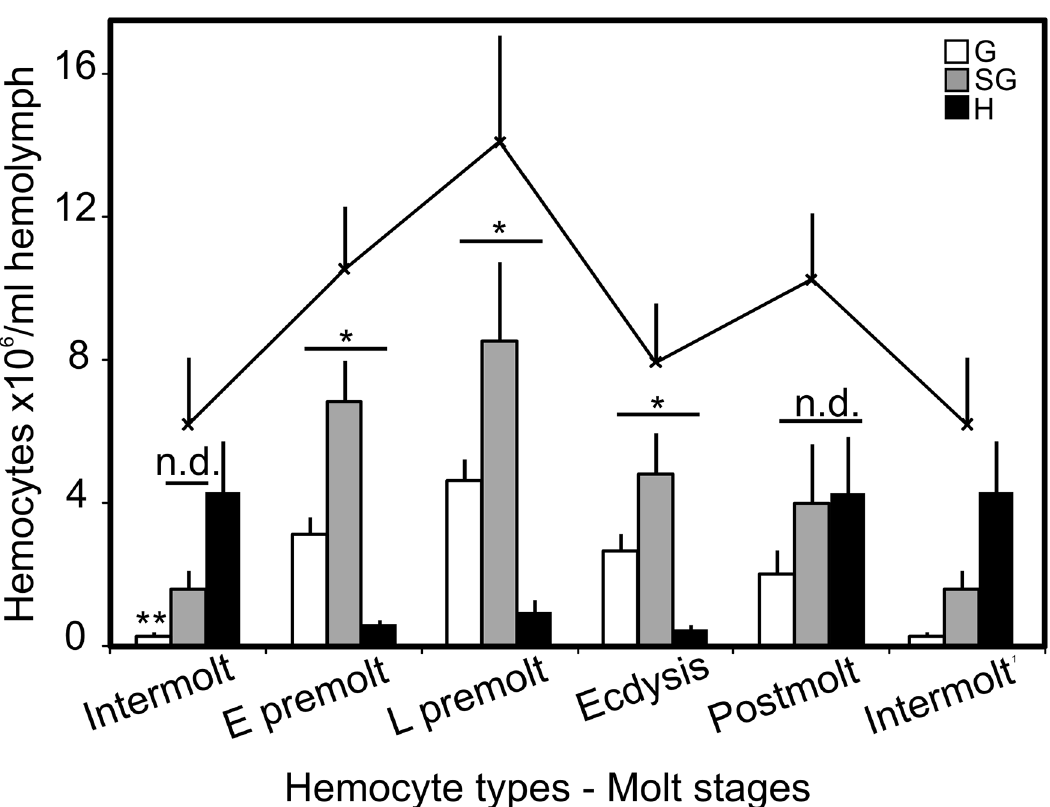
Fig 4. Differential hemocyte counting (DHC) during the molt cycle of C . sapidus using the flow cytometry analysis. The values of THC (solid line) do not significantly differ among the different molt stages (n = 18). Each bar represent a hemocyte type. n.d. = no difference; the ‘ * ’ and ‘ ** ’ denote significant difference at P < 0.05 and P < 0.01 (two way ANOVA), respectively. G = granulocytes; SG = semigranulocytes; H = hyaline cells.